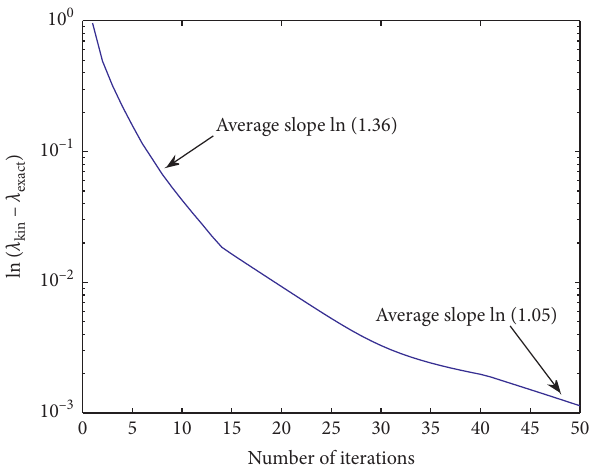
Figure 7: Variation of the convergence rate.